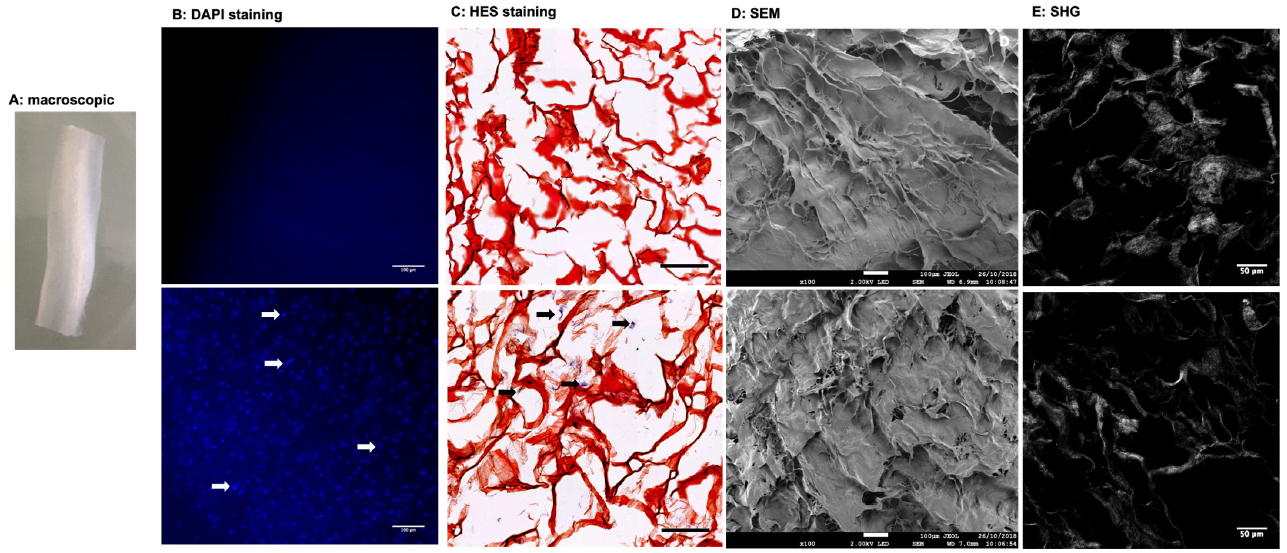
Figure 1. Structural features of decellularized (upper line) and devitalized (lower line) Wharton’s Jelly matrix. ( A ): Macroscopical view of DC-WJ. ( B ): Fluorescence microscopy visualization of DAPI stained nuclei (scale bar = 100 µm), ( C ): Hematoxylin-eosin-Safran (HES) staining of paraffin-embedded sections. (scale bar = 200 µm). White and black arrows highlight stained nuclei (blue and purple color, respectively). ( D ): Scanning electron microscopy (SEM) views (scale bar = 100 µm) and ( E ): Two-photon excitation laser scanning confocal microscopy and second harmonic generation (SHG) (scale bar = 50 µm).